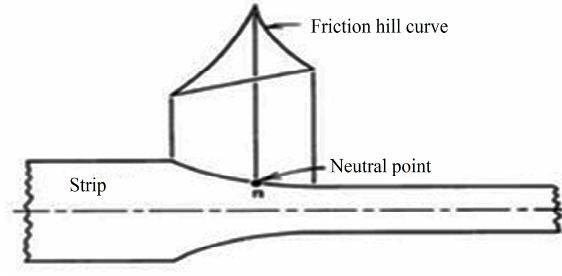
Figure 8. Compression of a strip between two work rolls [21].